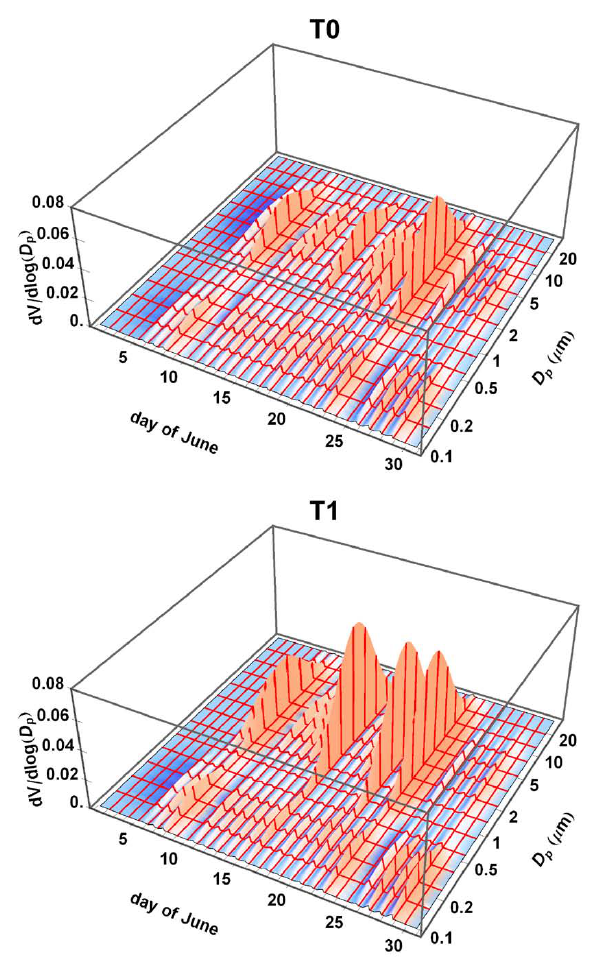
Fig. 21. Daily average volume size distributions derived from MFRSR observations at T0 and T1 ground